Question: What does this figure show? Answer in one sentence.
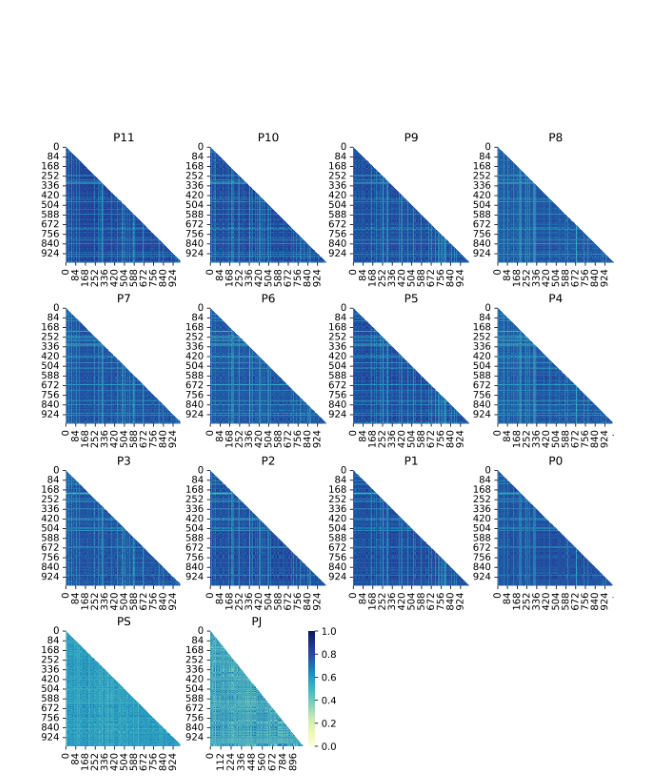
Answer: Correlation heat map of similarity measures across 1000 used vehicles for different approaches (Similarity scores ranging between 0 and 1 imply 0 as entirely distinct and 1 as complete similarity between vehicle items)